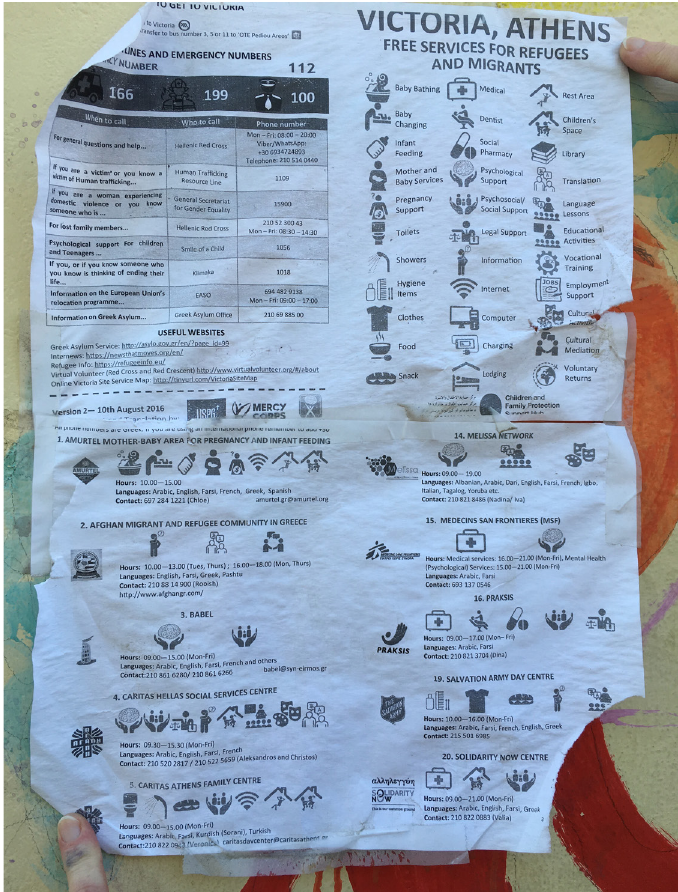
Fig. 2. Poster at Lesvos Solidarity articulating with welcome in Athens and prefiguring citizenship rights to free services. Photograph by Matthew